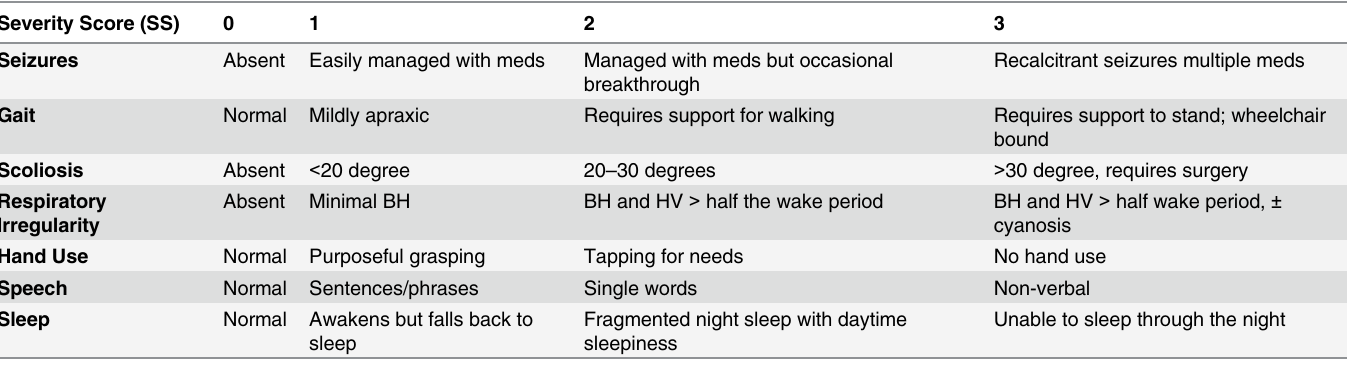
Table 1. Clinical severity score